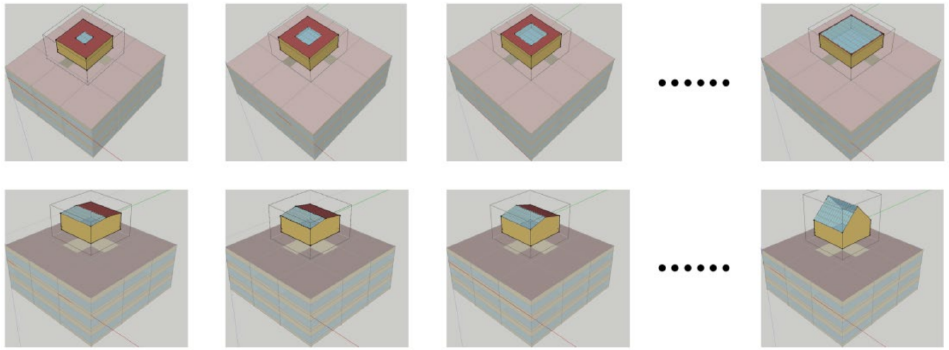
Figure 3. Changing sequences of STPV skylights in the studied